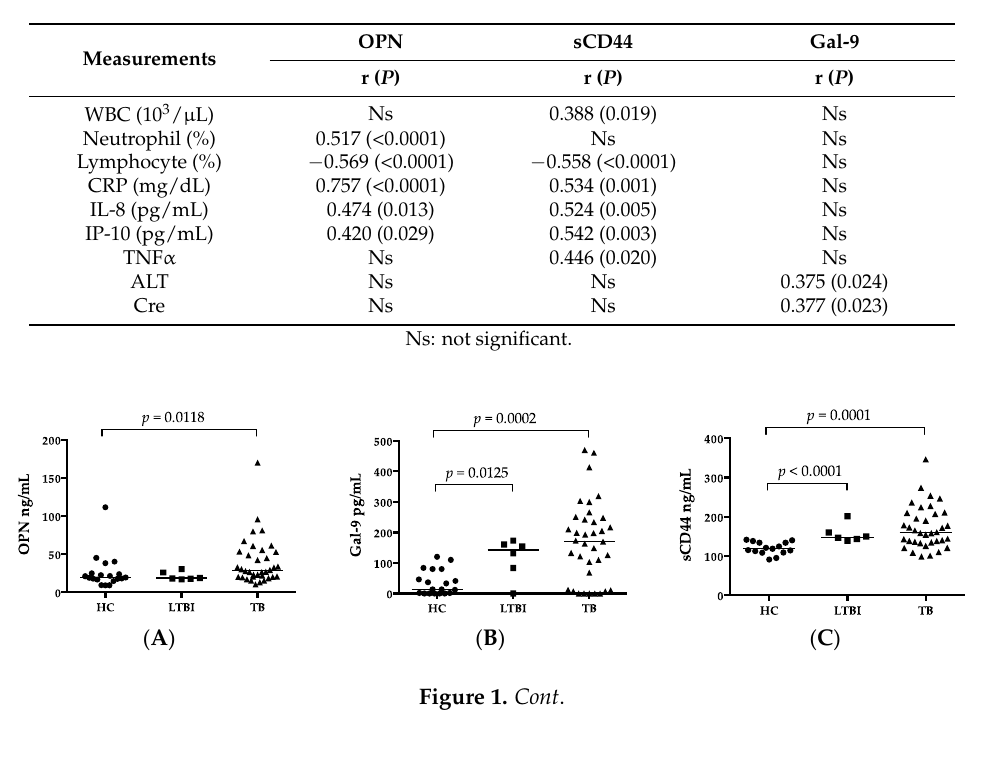
Table 3. Correlations of OPN, Gal-9, and sCD44 with other laboratory parameters and biomarkers in TB patients.